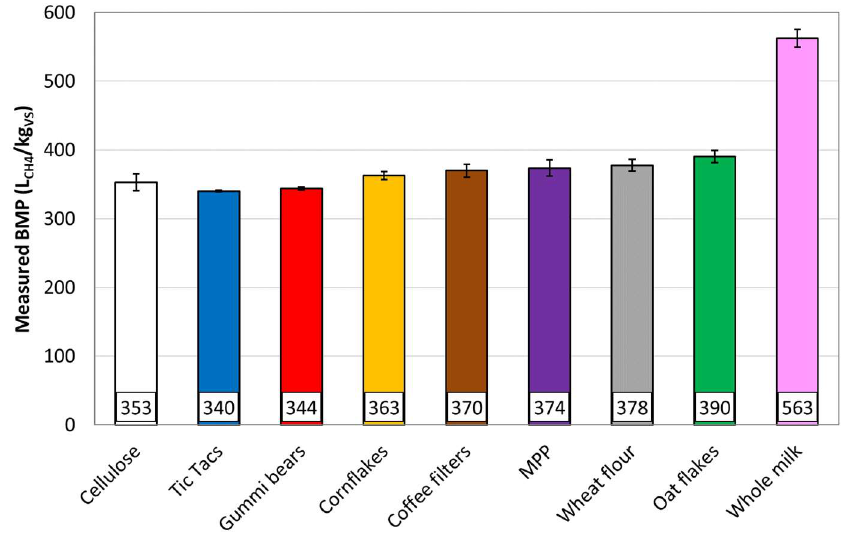
Figure 5. Measured BMP for microcrystalline cellulose and alternative positive control substrates. Error bars indicate standard deviation ( n = 9 for microcrystalline cellulose and n = 3 for all other substrates). Values have been sorted in ascending order.